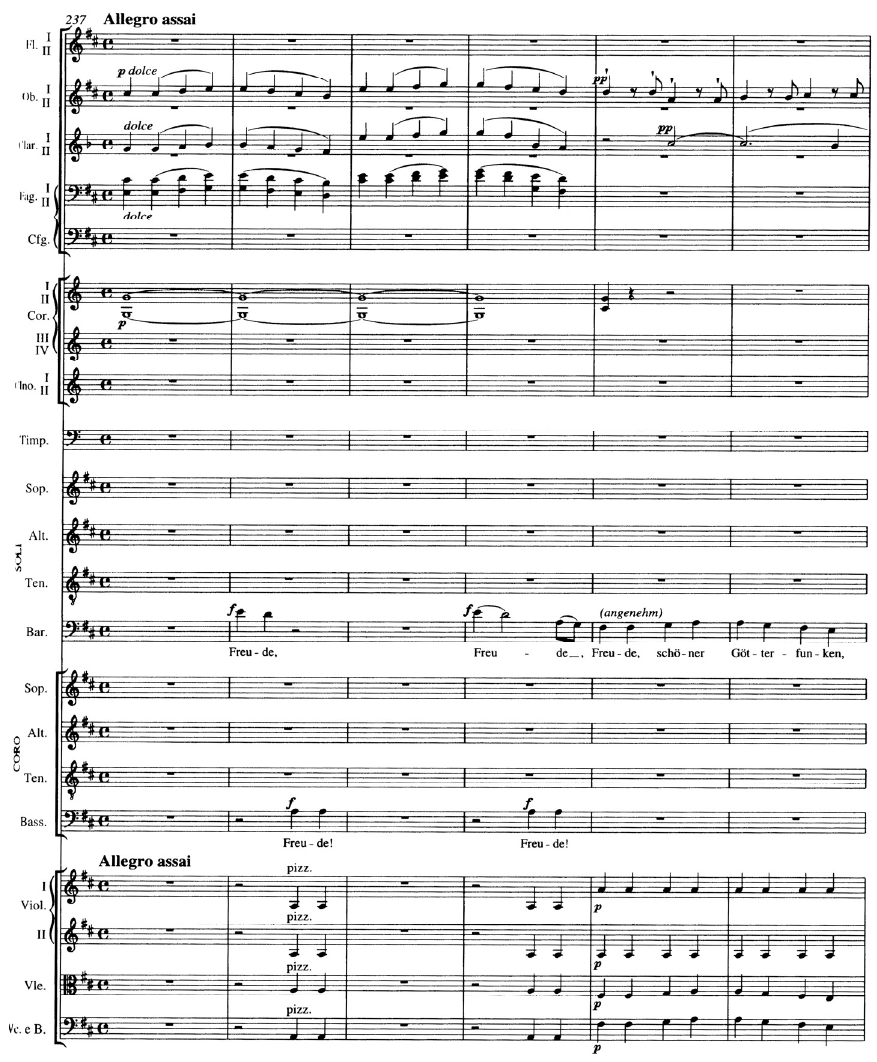
Figure 1. Ludwig van Beethoven, Symphony No. 9 in D Minor, Op. 125, Finale. Urtext edited by Jonathan Del Mar, Kassel: © 1999, Bärenreiter-Verlag. Finale, Allegro assai, mm. 237–241. Used with permission of Bärenreiter-Verlag,